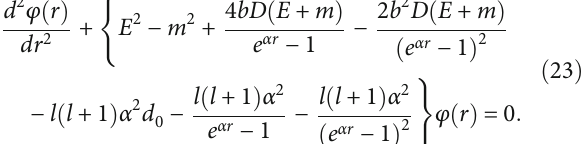
ffiffiffiffiffiffiffiffiffiffiffiffiffiffiffiffiffiffiffiffiffiffiffiffiffiffiffi